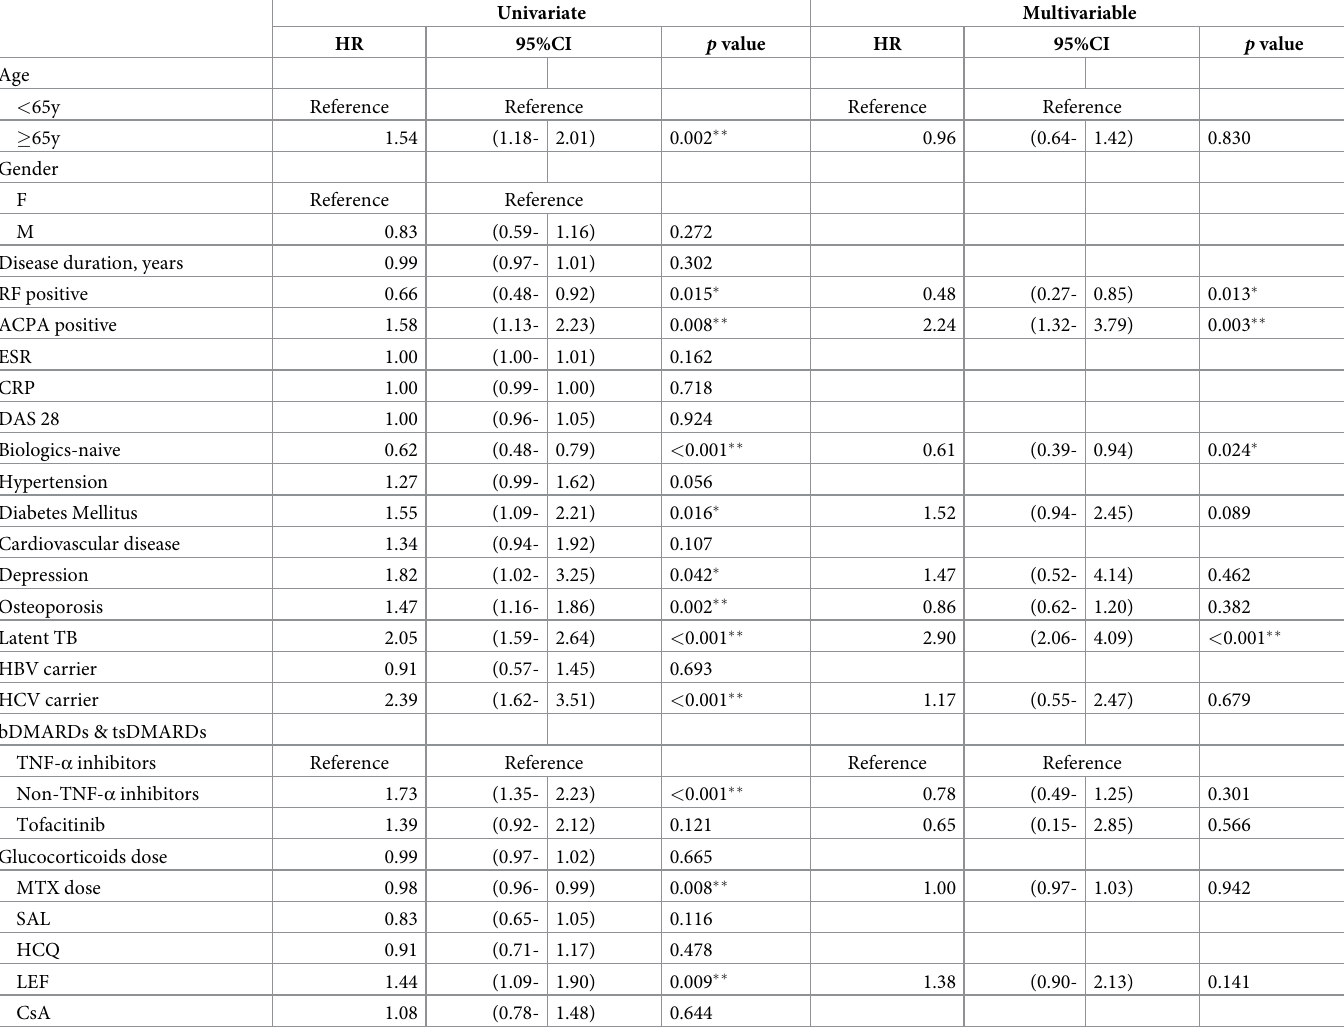
Table 2. Cox regression analysis of factors associated with 3-year drug survival in RA patients receiving bDMARDs and tsDMARDs